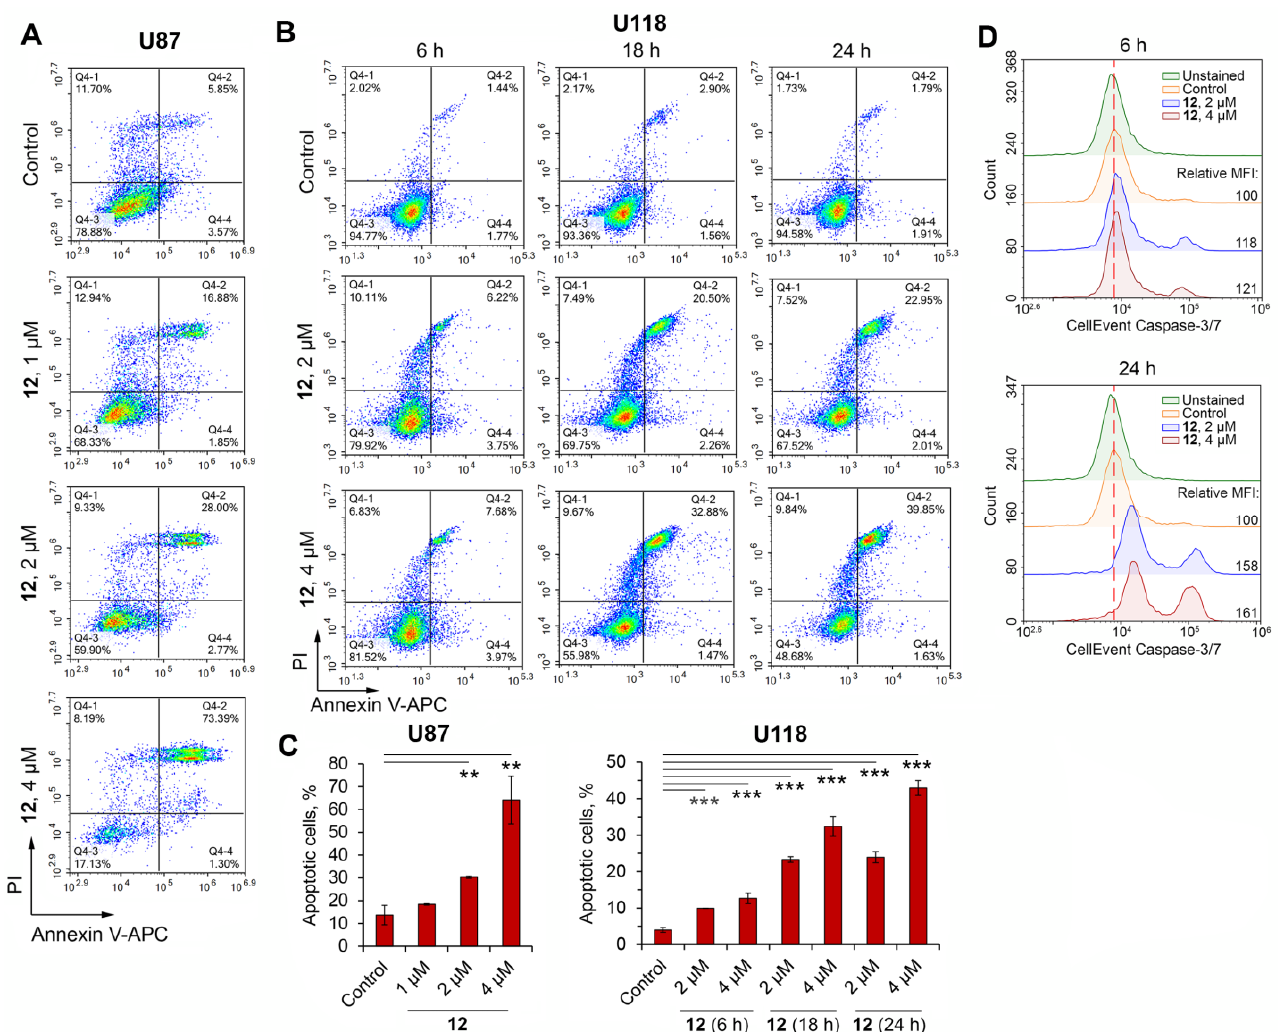
Figure 4. Evaluation of the pro-apoptotic activity of 12 in glioblastoma cells. ( A , B ) Time- and dose-dependent effect of 12 on the apoptosis of U87 ( A ) and U118 ( B ) glioblastoma cells evaluated by Annexin V-APC and propidium iodide (PI) double-staining test using flow cytometry. Cytograms show representative experiments. In total, 10,000 events were collected. ( C ) Histograms showing the percentages of apoptotic cells in the control and compound 12 -treated groups. Data are presented as means ± SD of three independent experiments. ** p < 0.01; *** p < 0.001. ( D ) Representative histogram plots overlay of caspase-3/-7 fluorescence intensity in U87 and U118 cells exposed to 12 . The cells were stained with CellEvent TM Caspase-3/7 reagent and analyzed by flow cytometry. MFI: mean fluorescence intensity.